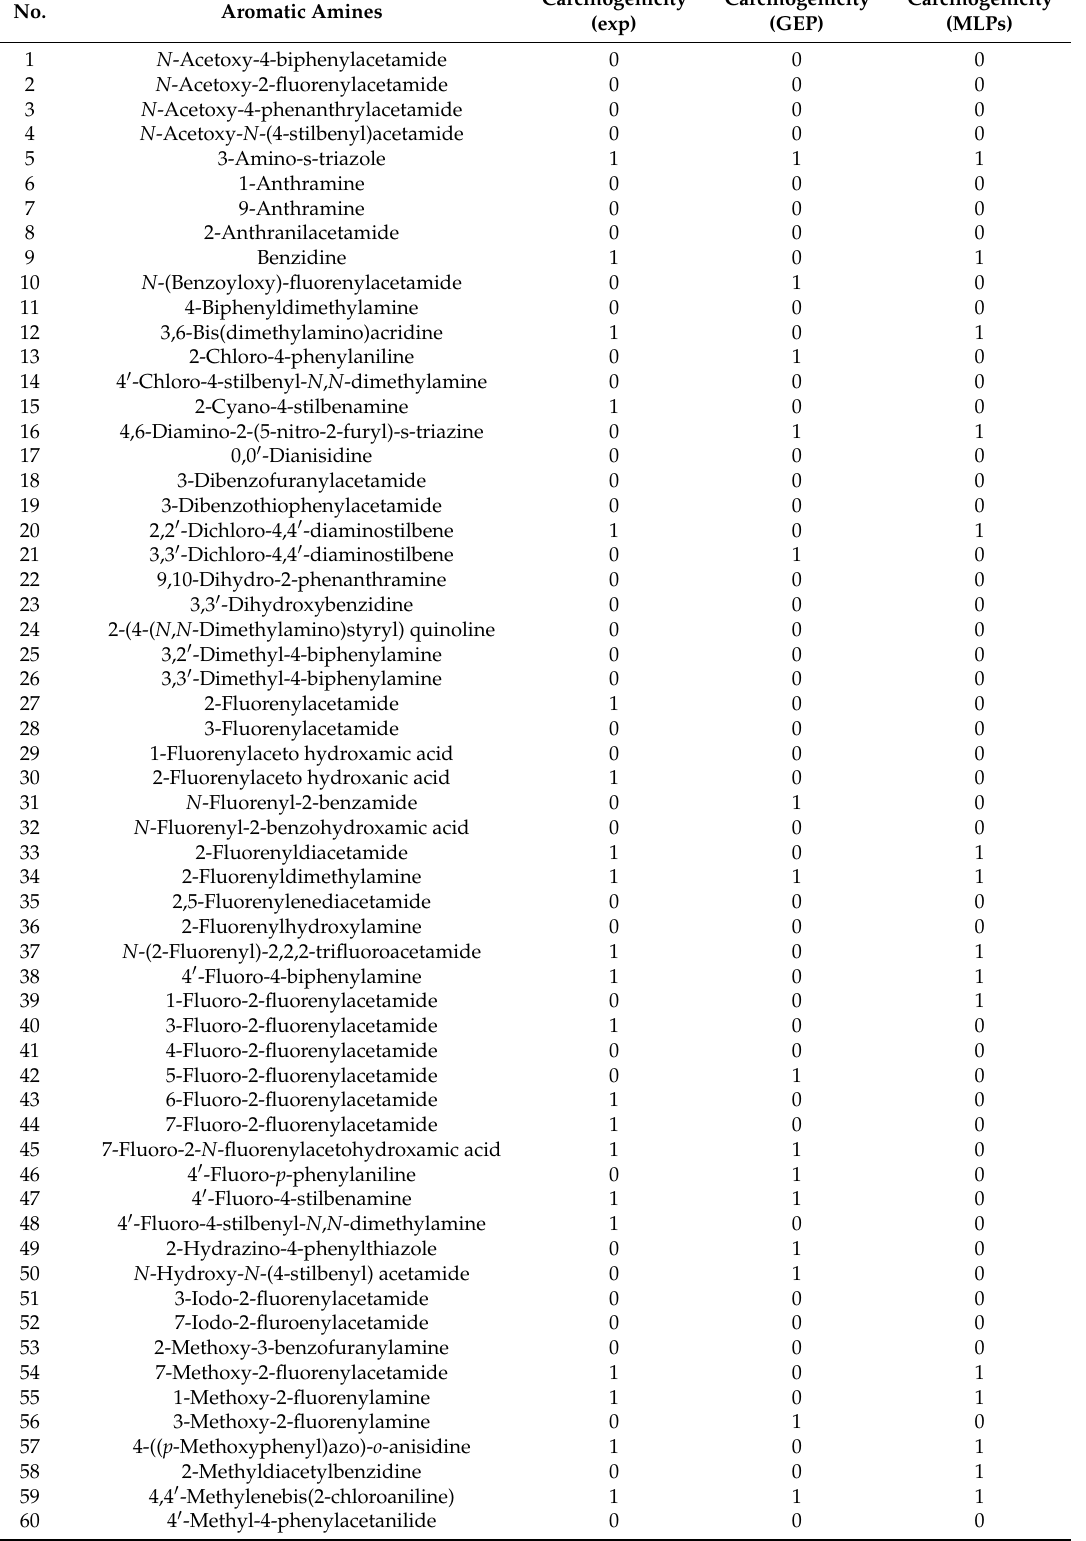
Table 1. Carcinogenic activity of aromatic amines for training